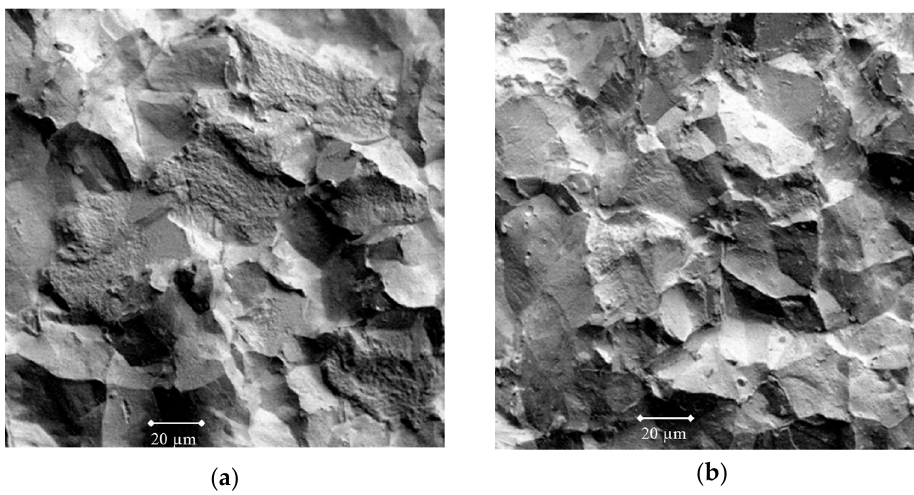
Figure 12. Fracture appearance of 18Cr-10Ni-Ti steel specimens irradiated at BOR-60 at 400–450 °C to 49 dpa (3–13% void swelling); showing IG and channel facets after tensile tests at: ( a ) 20 °C; ( b ) 290 °C [34]. Reproduced with courtesy of V. S. Neustroev. Copyright 2009 by The American Society of Mechanical Engineers (ASME). Acknowledgment to use with the permission.